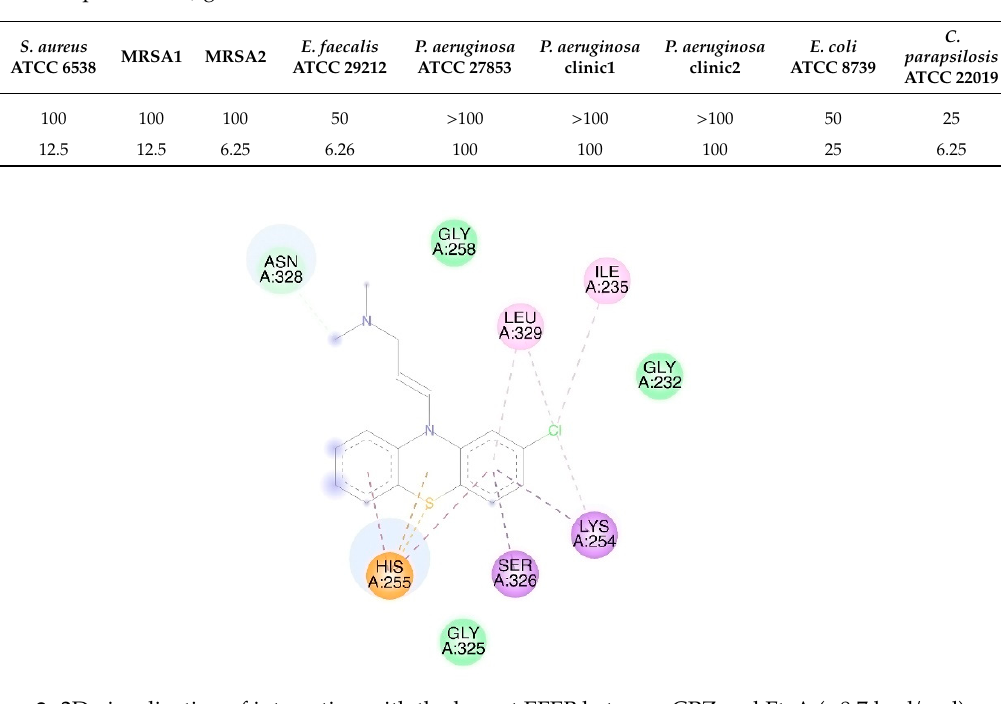
Table 3. MIC values for non-irradiated and laser irradiated solutions, against di ff erent microbial strains.